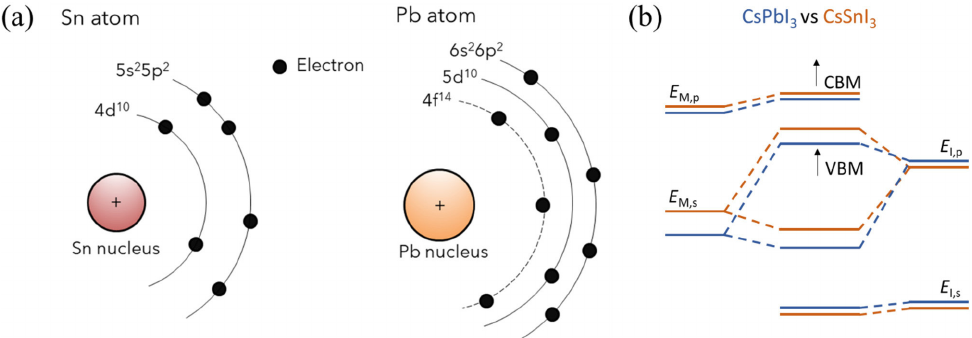
Figure 1. The crystal structures of perovskite semiconductors and their symmetry. Reprinted with permission under Creative Commons Attribution License [26]. Copyright 2018, Wiley-VCH. Table 1. Tolerance factor of tin halide perovskites.